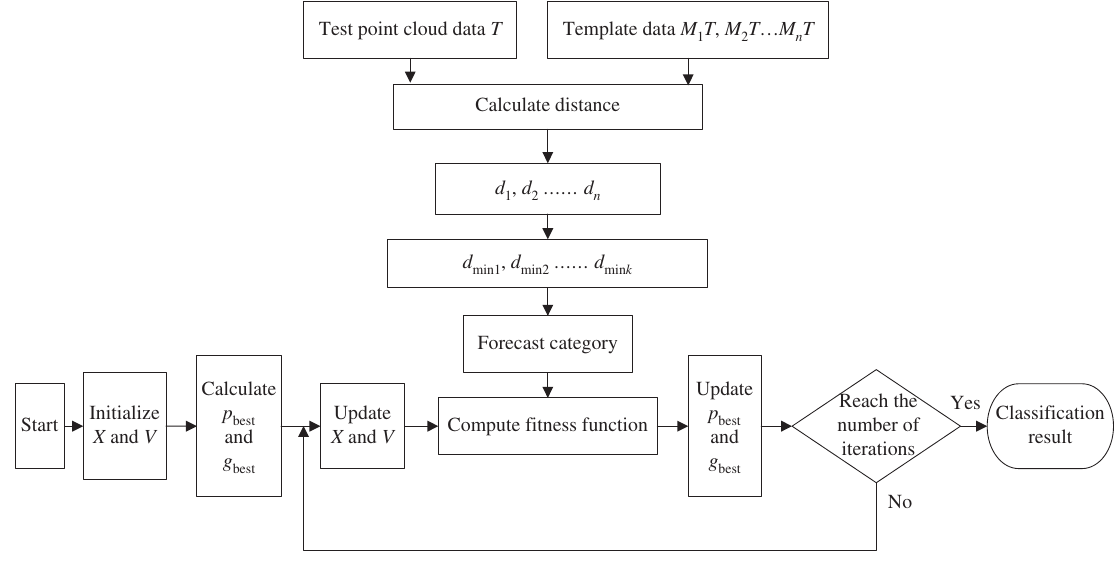
Figure 5: Implement